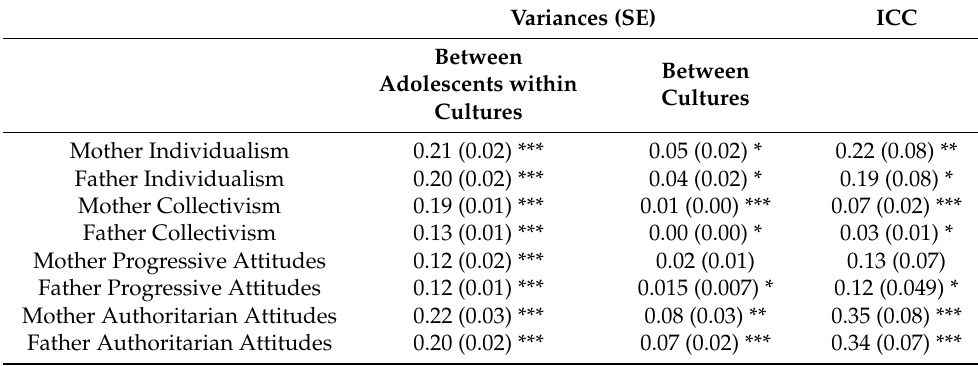
Table 3. Estimated variances and intra-class